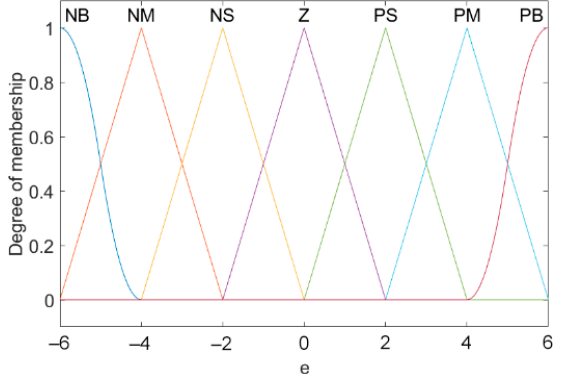
Figure 8. Membership function of 𝑒(𝑘) .